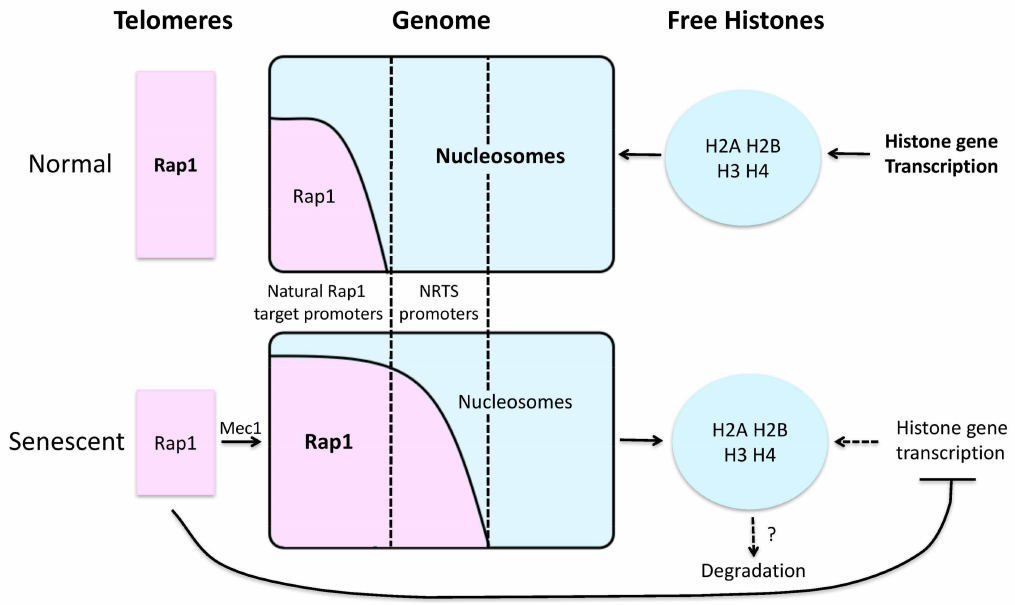
Figure 1. Rap1 relocalization at senescence in telomerase-deficient yeast leads to global and site-specific histone losses. Shown are the relative levels of Rap1 and histone proteins at telomeres, nontelomeric genomic regions, and in non-chromatin-bound histone pools. In normal cells, Rap1 is clustered at telomeres and is present at the promoters of natural Rap1 target genes. When cells become senescent due to critically short telomeres, Rap1 relocalizes to the promoters of natural and new Rap1 targets at senescence (NRTS). This relocalization depends on the Mec1 checkpoint kinase, which is activated by uncapped telomeres. At NRTS promoters, Rap1 binding displaces histones, resulting in site-specific histone losses. Rap1 also relocalizes to the promoters of histone genes and inhibits their transcription. Thus, the increased availability of Rap1 together with a decline in histone